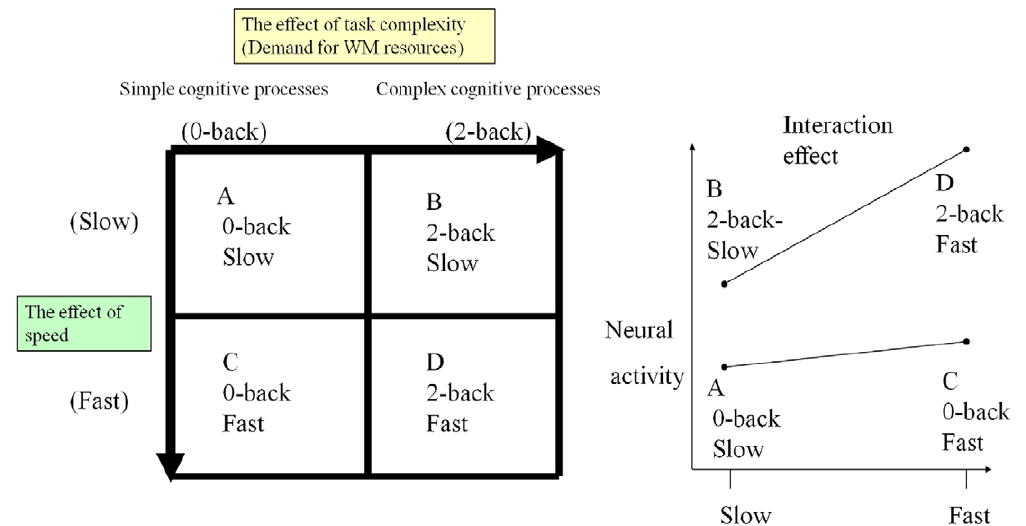
Figure 1. Our conceptual schema of the difference between the effect of speed on simple cognitive processes and on complex cognitive processes, as well as our two factorial task design. We assumed the critical difference between simple and complex cognitive processes (one of the main effects: {(B + D) 2 (C + A)} was the demand for WM resources, based on previous studies. (C 2 A) is the effect of speed on simple cognitive processes, and (D 2 B) is the effect of speed on complex cognitive processes (See the left figure). The purpose of this study was to reveal the neural correlates responsible for the difference in processing speed between simple and complex cognitive processes ({(D 2 B) 2 (C 2 A)} interaction effect in the design. See the right figure).